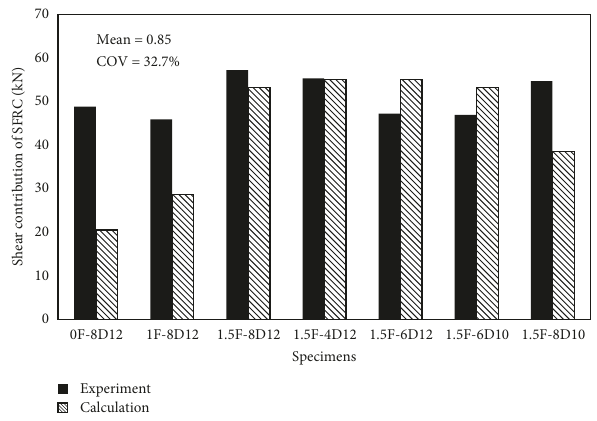
Figure 11: Comparison in shear contribution of SFRC panels between experiment and